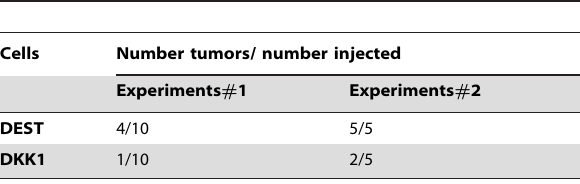
Table 1. Formation of subcutaneous tumors in CB17/SCID mice by SK-ES1 cells.